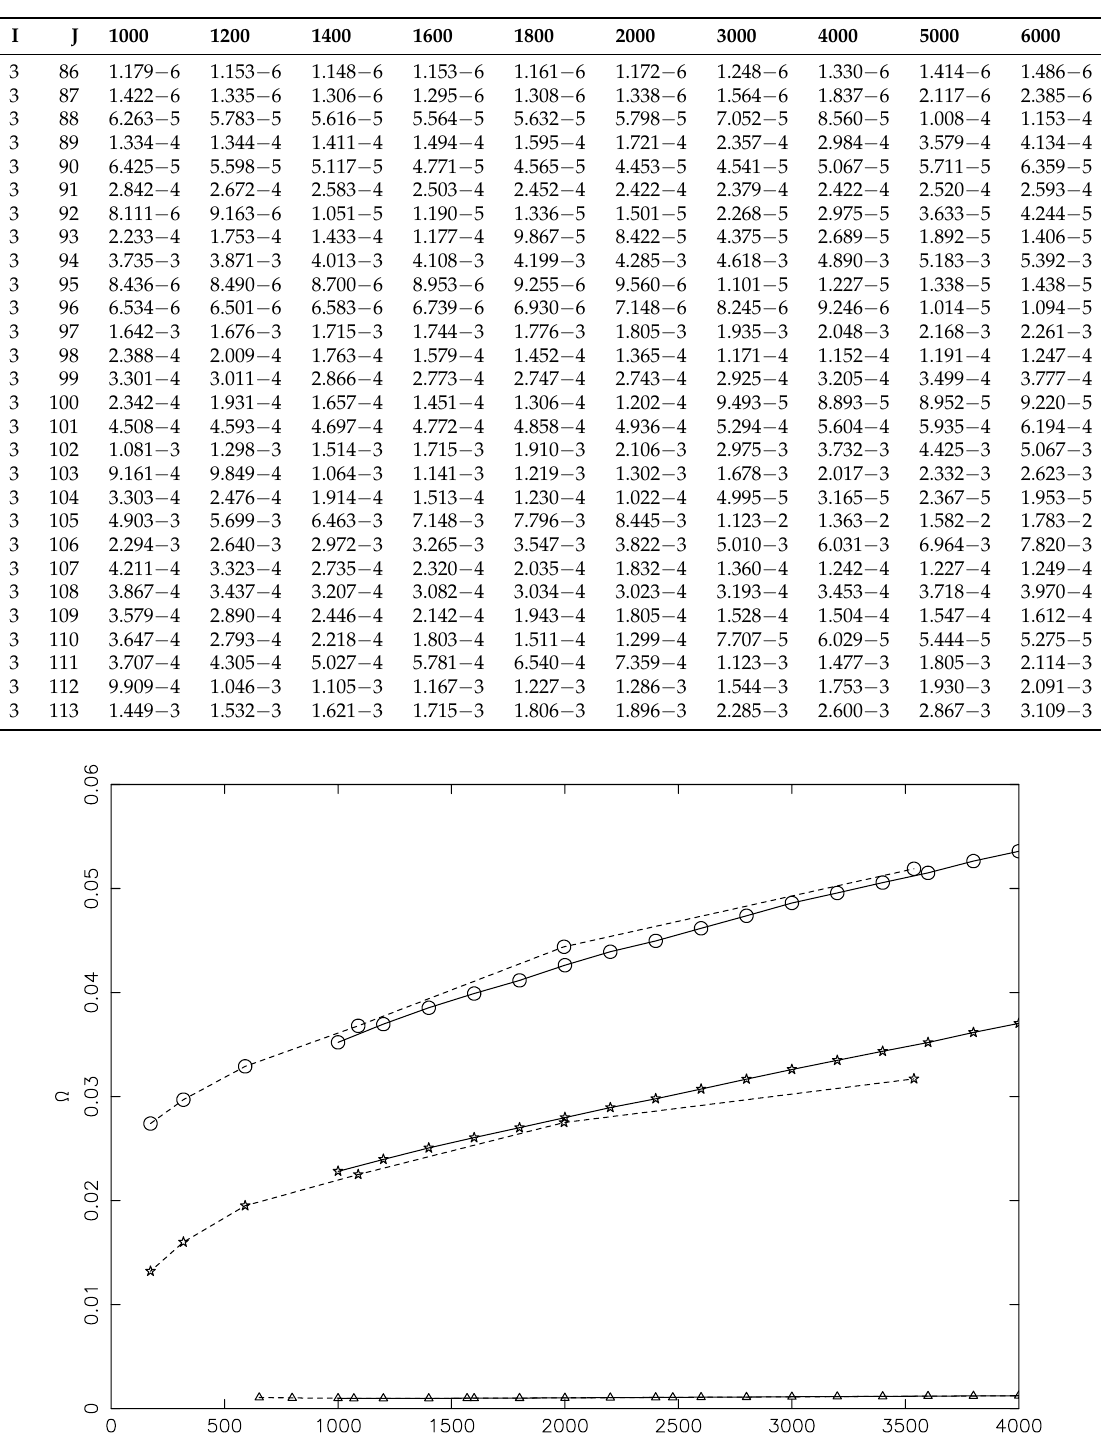
Figure 2. Comparison of collision strengths for the 1–3 (2s 2 2p 5 2 P o 1–8 (2s 2 2p 5 2 P o –2s 2 2p 4 3p 2 D o : triangles), and 2–3 (2s 2 2p 5 2 P o 3/2 5/2 of W LXVI. Continuous curves: present results, broken curves: results of Sampson et al.